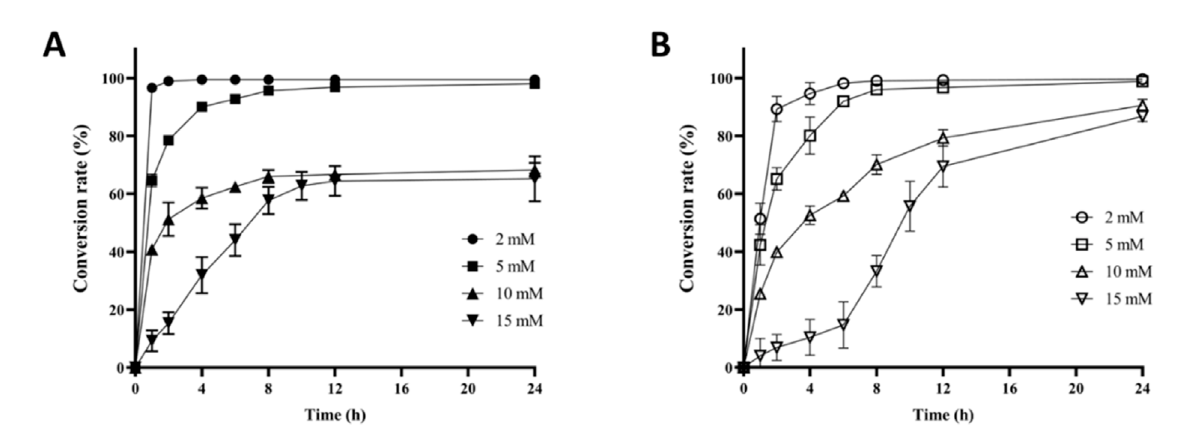
FIGURE 4 Overproduction of CC from PCC using two different methods. (A) The conversion rate of CC to PCC using EasC aj based CLC platform. (B) The conversion rate of CC to PCC using EasC aj based whole-cell catalysis (WCC)